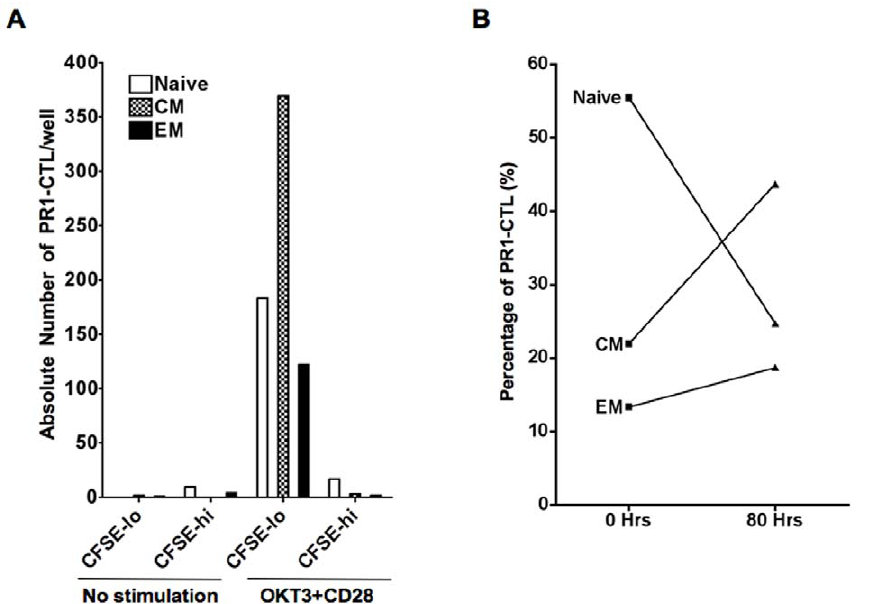
Figure 4. The phenotype of PR1-CTL changes from predominantly naı¨ve to memory upon stimulation. PBMC from patient 3 were labeled with CFSE, stimulated for 80 hours, then labeled with antibodies for analysis of surface phenotype by FACS to determine naı¨ve (N), central memory (CM), and effector memory (EM) cells, as described in the text. (A) The left panel shows the absolute number of PR1-CTL that proliferate after T cell receptor (TCR) stimulation with OKT3 and anti-CD28 antibodies. (B) The right panel depicts the percentage of PR1-CTL that were phenotypically categorized as N, CM, or EM before (time 0) and after (time 80 hrs) TCR stimulation. Prior to stimulation, PR1-CTL were predominantly naı¨ve (N) phenotype and following stimulation PR1-CTL were predominantly CM phenotype.